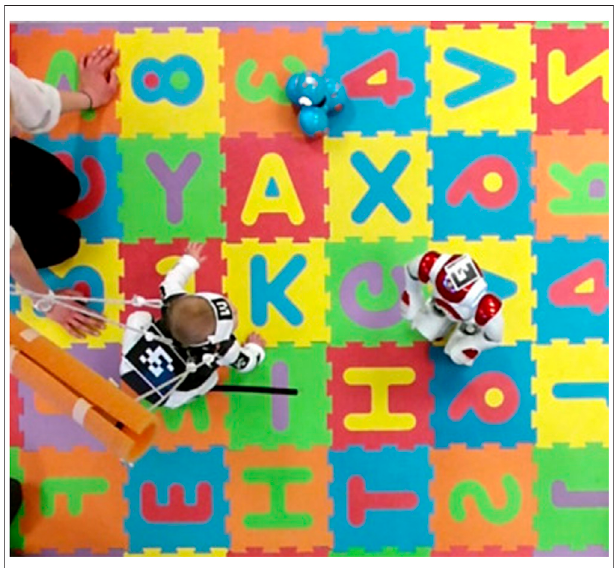
FIGURE 5 | Instance of play-based child-robot social interaction. Two robots are visible in the scene: a small humanoid NAO , and a differential-drive small mobile robot toy DASH .